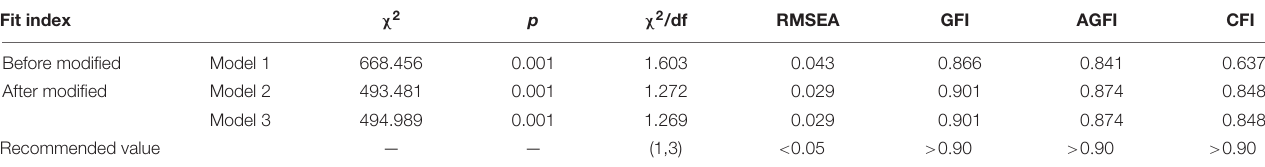
TABLE 5 | Model-fit indices.